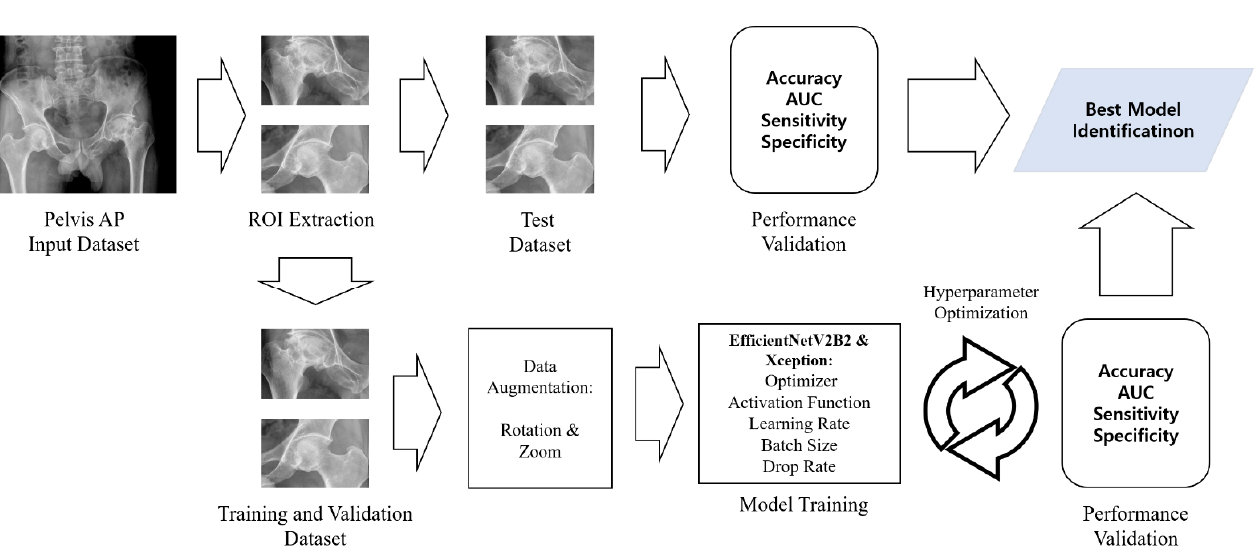
Figure 1. Diagram of osteonecrosis of the femoral head classification process. AP, anteroposterior; ROI, region of interest, AUC: area under the curve. Table 1. Performances of deep ‐ learning models for diagnosing osteonecrosis of femoral head. ONFH (Right Hip) Diagnosis Model ONFH (Left Hip) Diagnosis Model